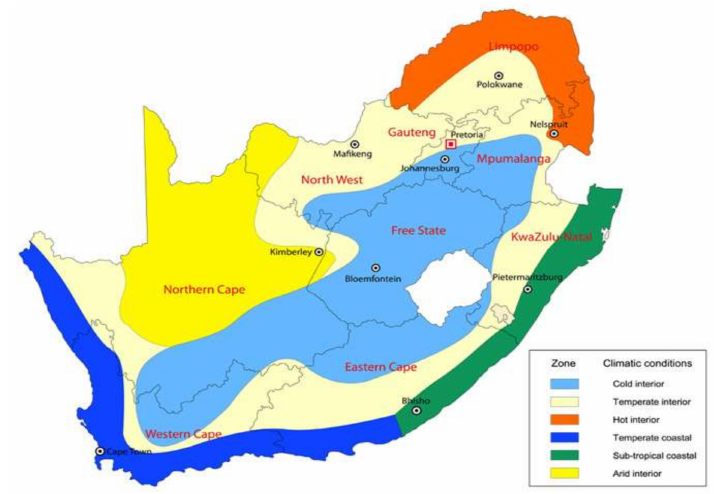
Figure 28. Climatic conditions in South Africa [41].